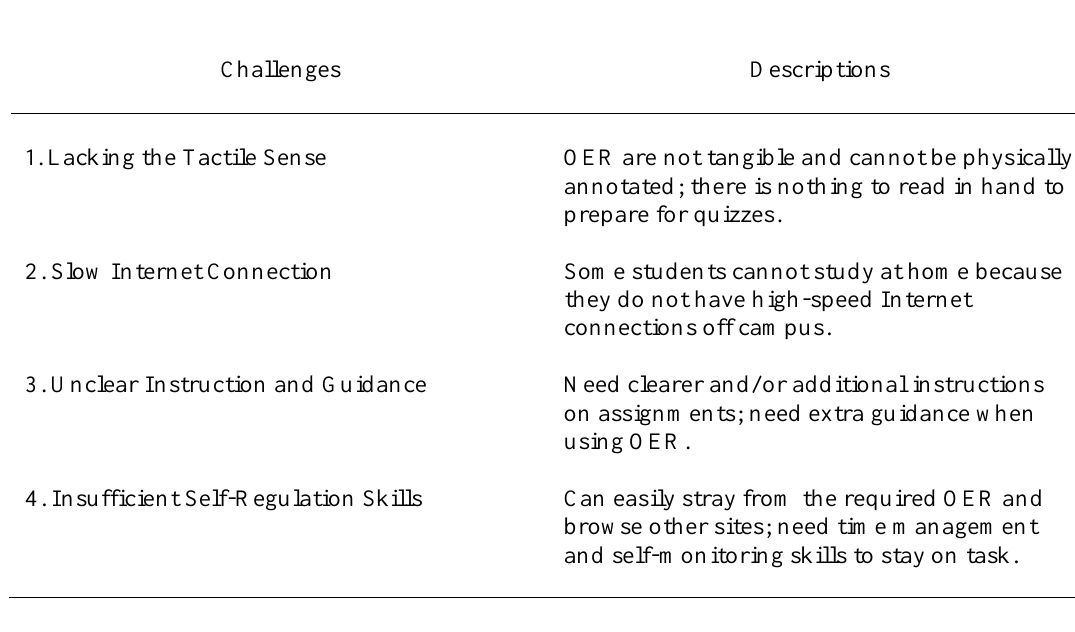
Challenges When Using Only